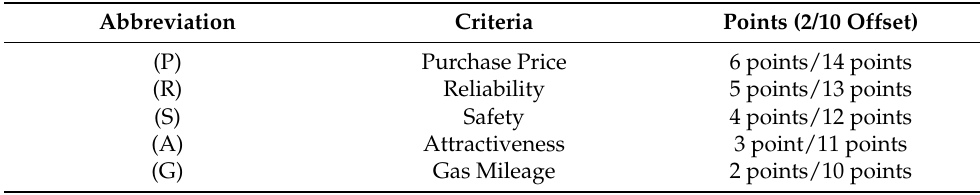
Table 9. Point calculation for pairwise method using offsets.